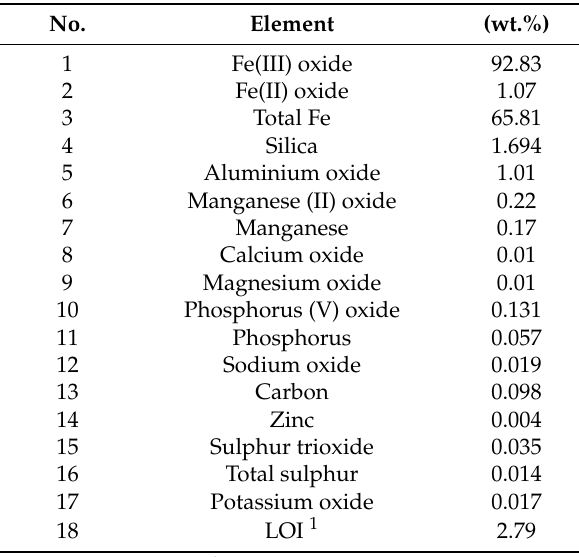
Table 3. Chemical composition (wt.%) of Carajas iron ore.